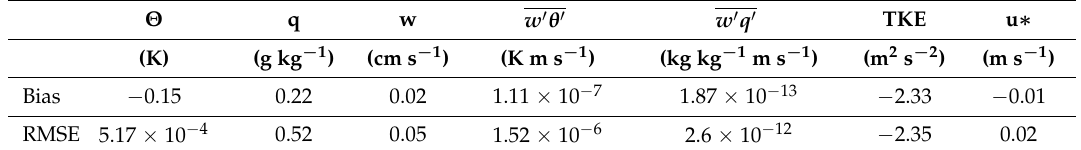
Table 1. Statistical comparison of BIAS and RMSE between 25 m and 50 m grid